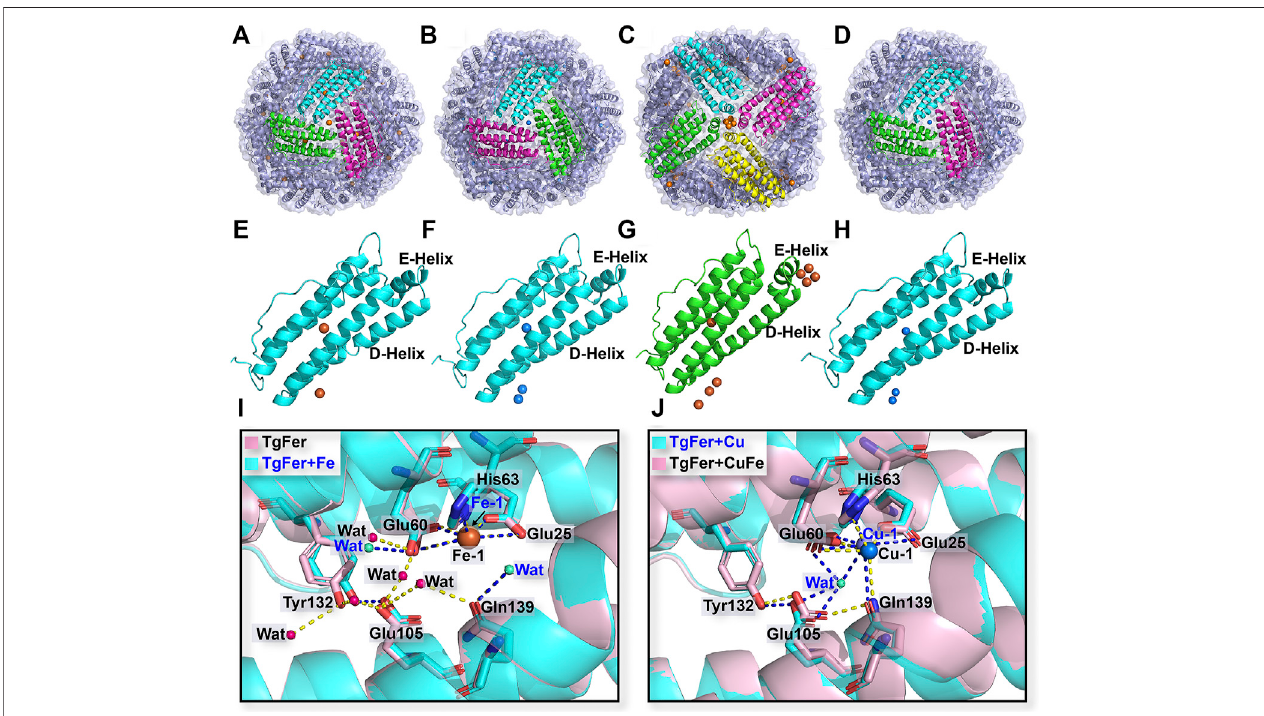
FIGURE4| OverallstructureofTgFer (A) ,TgFer+Cu (B) ,TgFer+Fe (C) ,andTgFer+CuFe (D) .AsingleferritinsubunitofTgFer (E) ,TgFer+Cu (F) ,TgFer+Fe (G) , andTgFer+CuFe (H) ,inwhichyellowandbluespheresrepresentedironandcopperions,respectively. (I) Thedetailedstructureoftheferroxidasesiteview,showingthe coordinationenvironmentofironions(yellowspheres)inTgFerandTgFer+Fe. (J) Thedetailedstructureofthecoordinationenvironmentofcopperions(bluespheres)at the ferroxidase site in TgFer + Cu and TgFer +